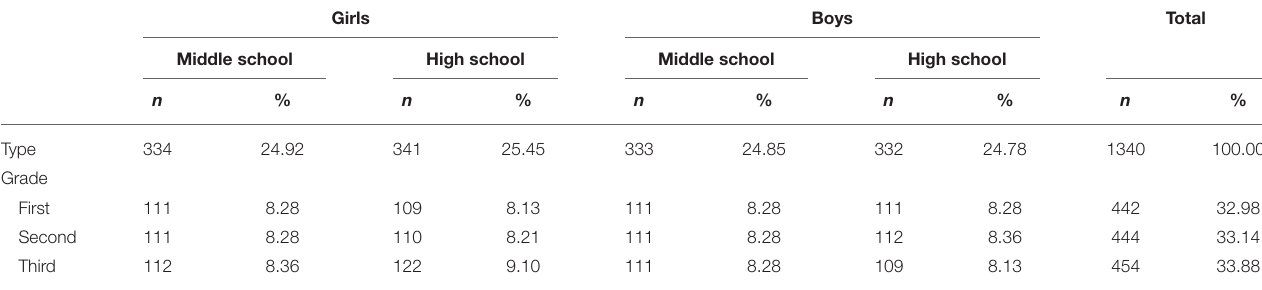
TABLE 1 | Demographic characteristics of the sample.